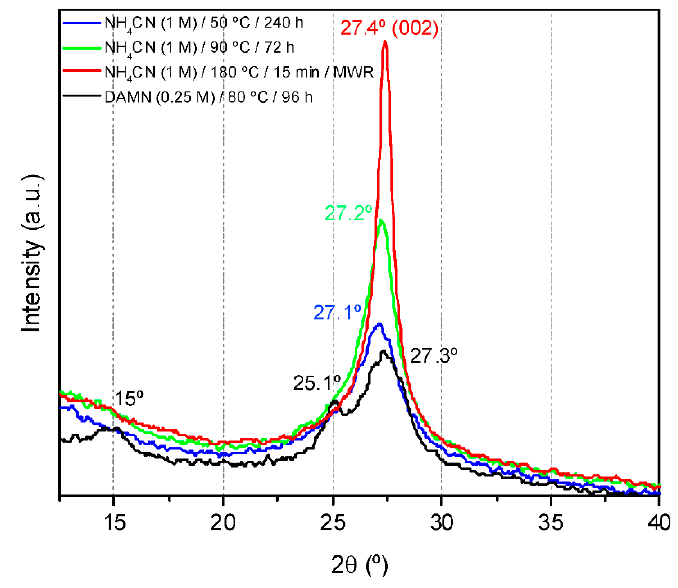
Figure 7. Representative X-ray diffraction patterns of NH 4 CN and DAMN polymers synthesized at different temperatures and at limit conversions for each case. MWR = microwave radiation. In all cases the HCN-derived polymers were produced in the presence of air.